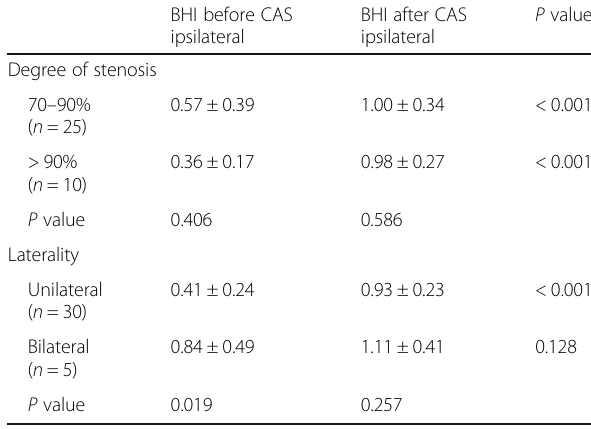
Table 4 BHI in patients with different pathology before